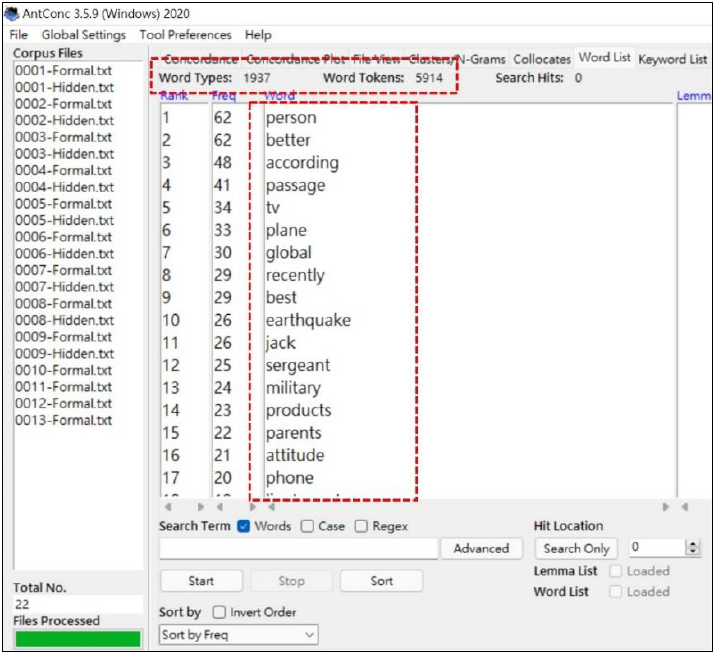
Figure 10. CEFR B1 level words that exist on the target corpus.